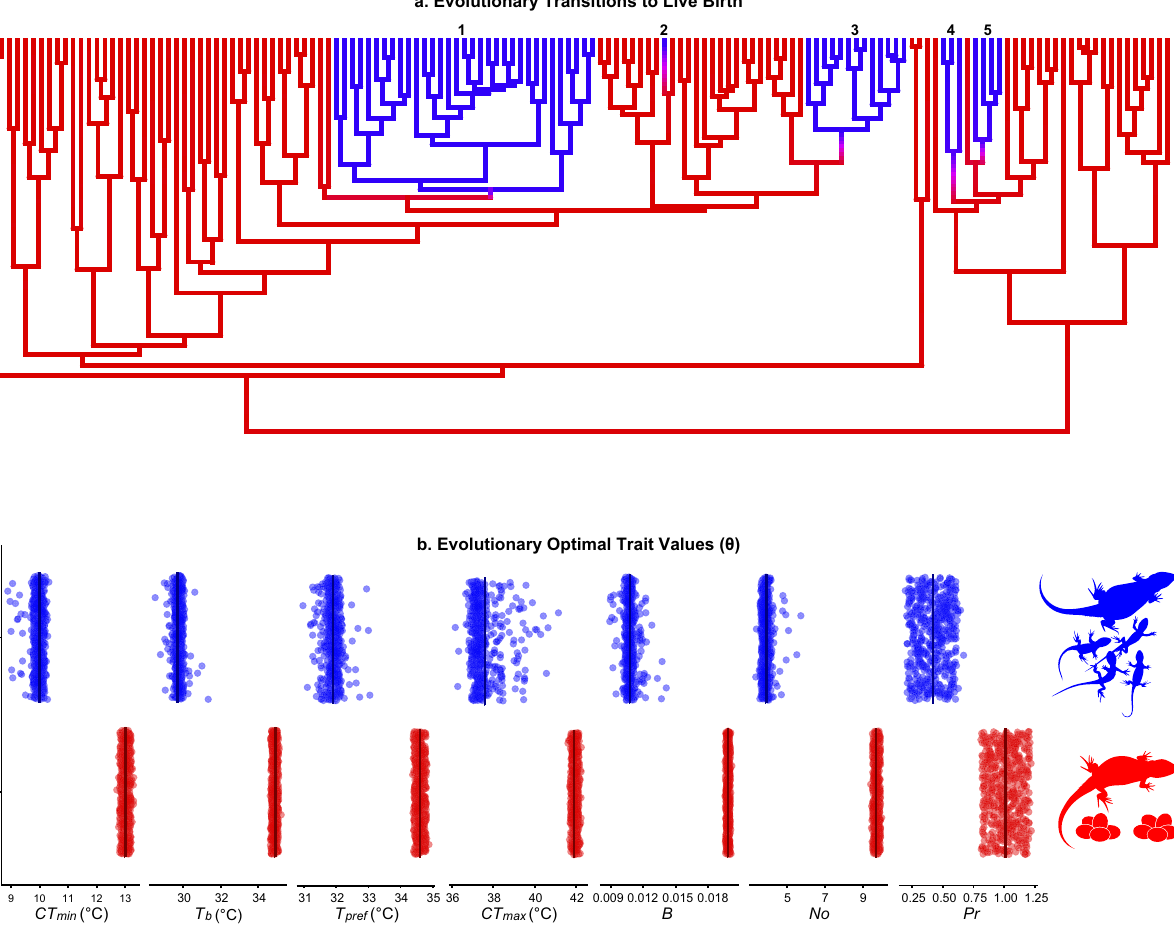
Fig. 1 Parallel reductions in physiological and life-history traits are associated with viviparity in phrynosomatid lizards. a Five evolutionary transitions from egg laying (red) to live-bearing (blue) occurred in phrynosomatids. b Viviparous lineages are characterized by reductions in the evolutionary optimal trait values ( θ ) for cold tolerance ( CT min ), fi eld-estimated body temperature ( T b ), the laboratory-measured preferred body temperature ( T pref ), heat tolerance ( CT max ), mass-speci fi c metabolic rate during activity ( B ), the annual number of offspring ( No ), and mass-speci fi c production ( Pr ). Evolutionary optimal trait values were inferred from the Ornstein-Uhlenbeck (OU) model- fi tting procedure (see Methods). Each point represents a different stochastic character map from our analyses across the maximum clade credibility tree ( n = 500 per trait). These patterns are matched with a strong signal of phenotypic convergence among viviparous species (Supplementary Table 6). Source data are provided as a Source Data fi